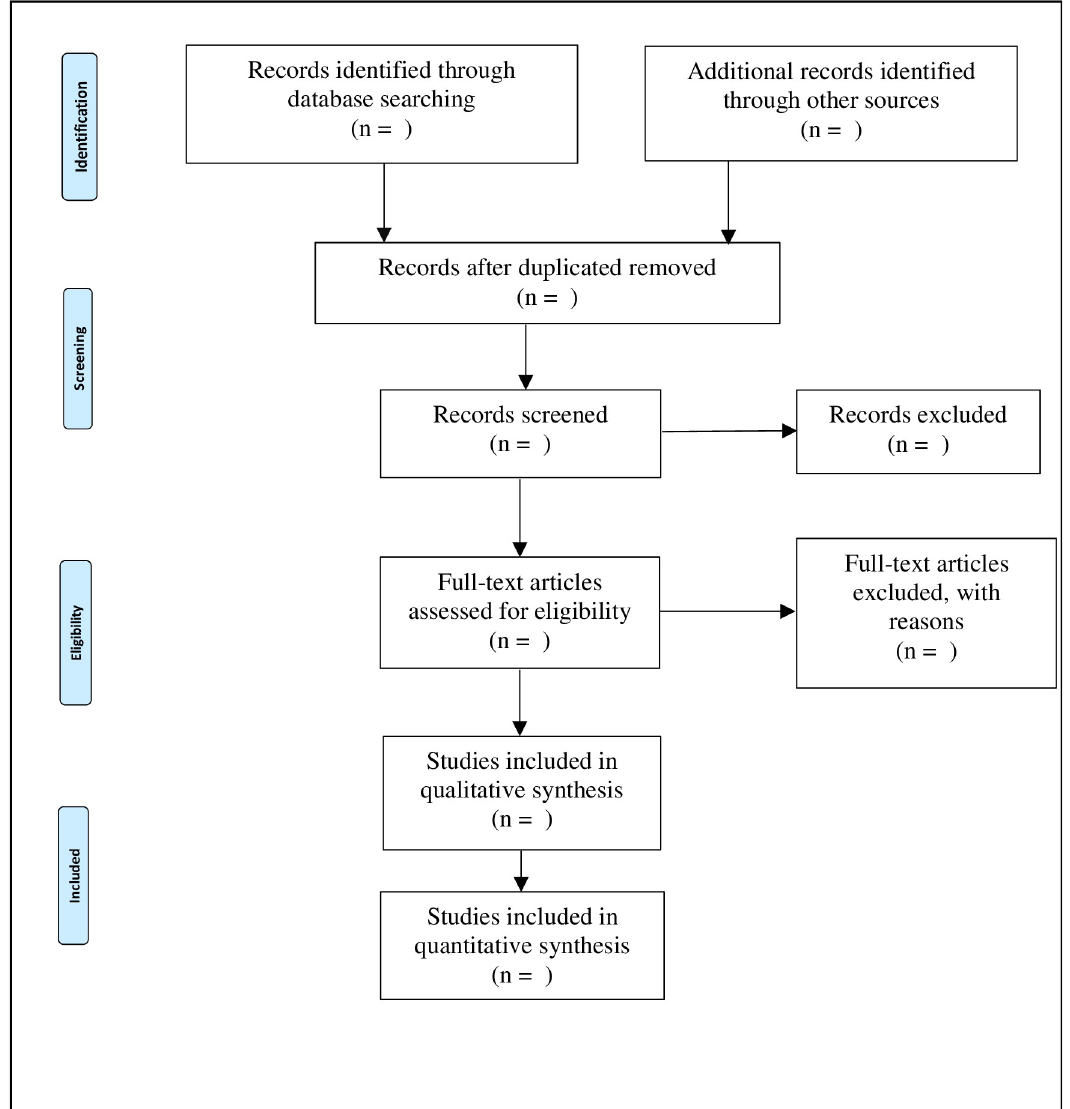
Fig 1. PRISMA flow diagram of the selection of studies to include in a systematic